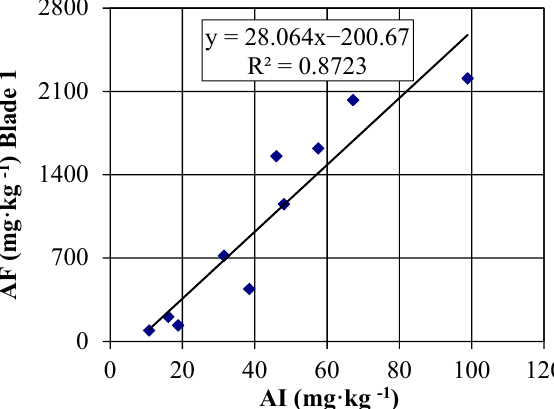
Figure 8. Scatter diagram of the results showing the relationship between Work Index (W i ) and Hardgrove Grindability Index (HGI), where 1 is the regression line W i upon HGI (R 2 = 0.5878).